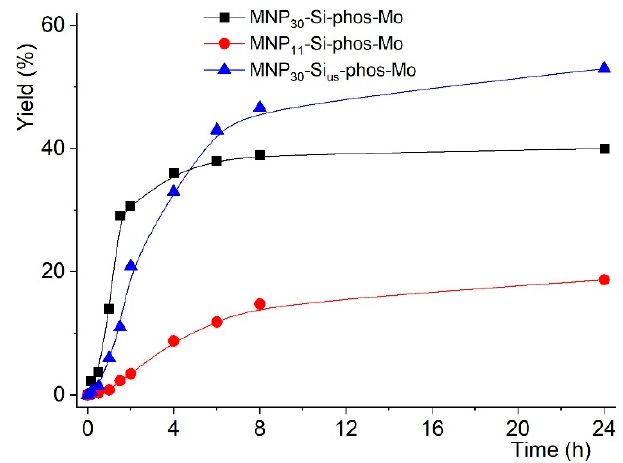
Figure 5. Styrene oxide yield with toluene as solvent at 383 K.